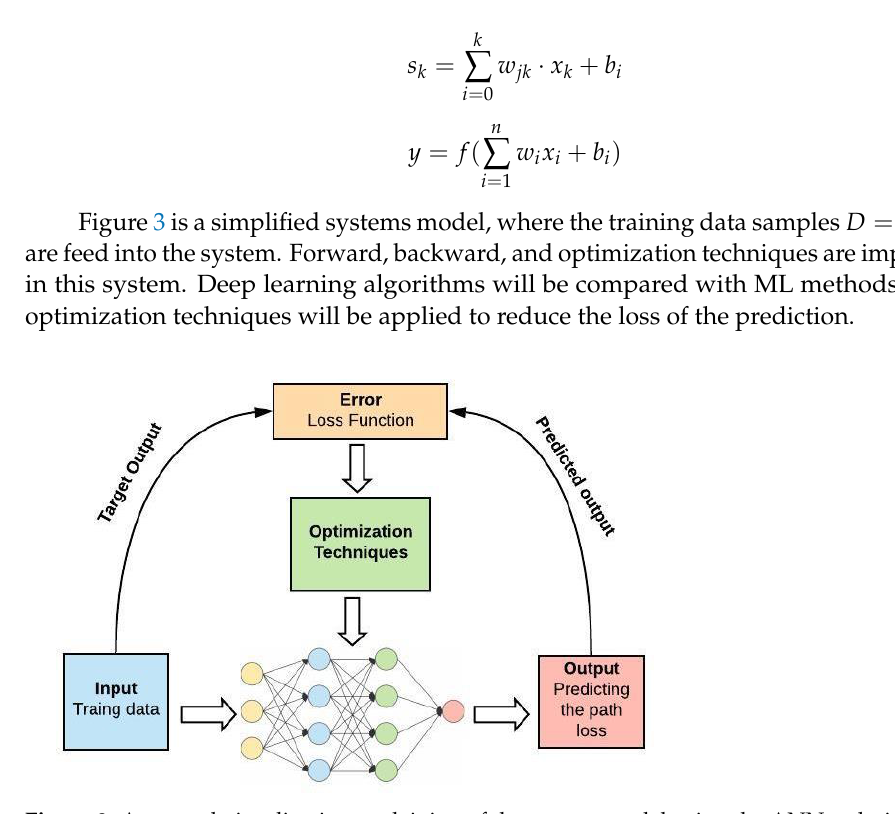
Figure 3. A general visualization explaining of the system model using the ANN